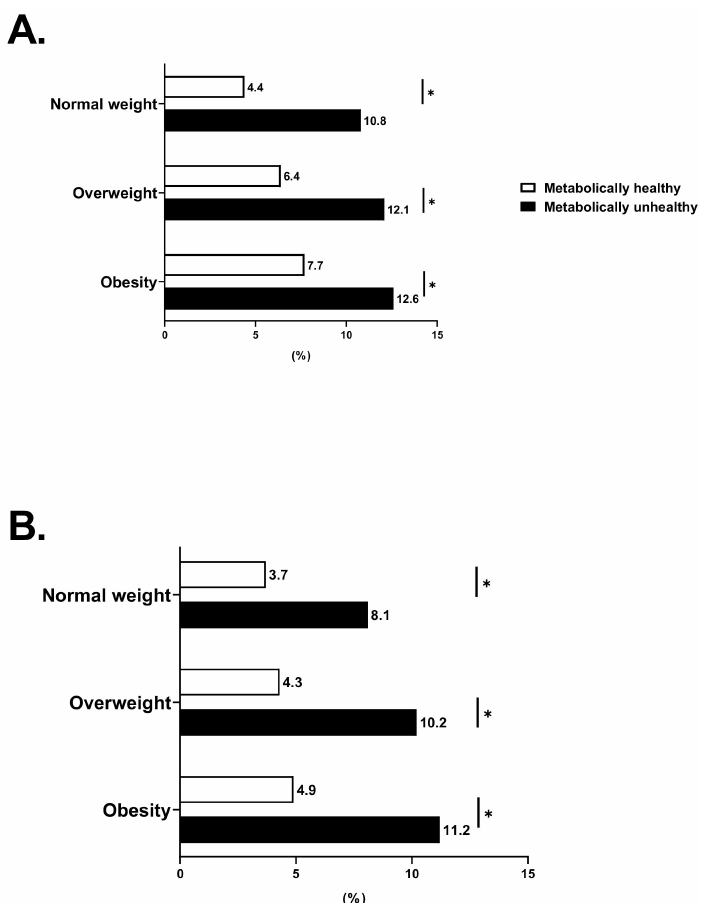
Figure 2. Prevalence of carotid atherosclerosis across categories of weight and metabolic status: based on new definition ( A ) and based on the National Cholesterol Education Program–Adult Treatment Panel III (NCEP-ATPIII) criteria (NCEP definition). ( B ). * p < 0.05 compared between metabolically healthy group and metabolically unhealthy group according to body mass index (BMI)